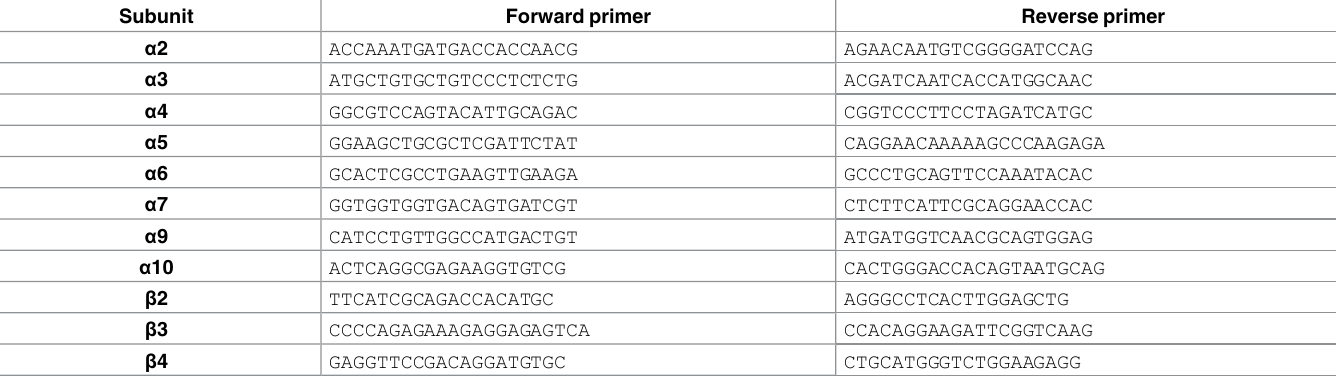
Table 1. Primer sequences for Nicotine receptor subunits